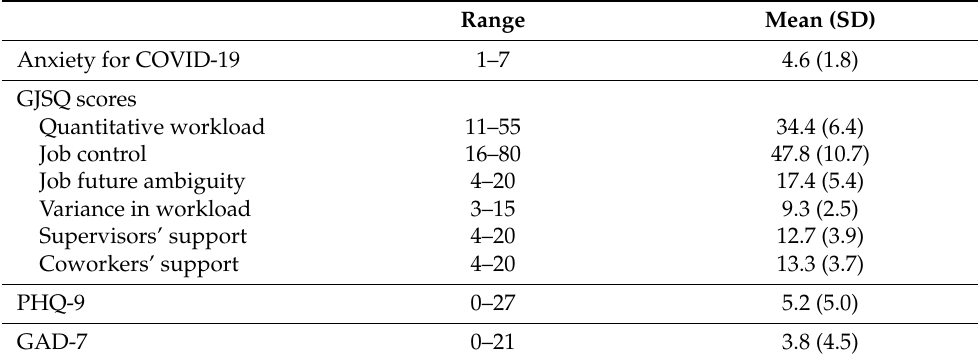
Table 2. Participants’ occupational stress, depressive, and anxiety symptoms (N =